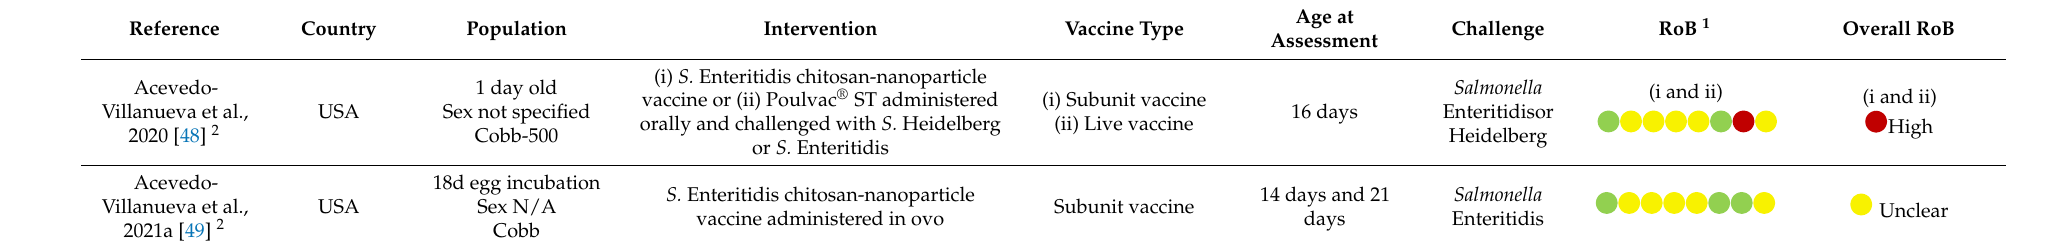
1 Risk of bias was assessed in the order of: Sequence generation, Allocation concealment, Timing of identification and Recruitment of individual participants, Blinding of participants and personnel, Blinding of outcome assessors, Incomplete outcome data, Selective outcome reporting and Other sources of bias. Assess- ment for each domain is represented in green (low risk of bias), yellow (unclear risk of bias) and red (high risk of bias). 2 Studies that did not have a unit of analysis error. Note: Population age refers to the bird’s age at the beginning of the intervention. Table 3. Summary of key characteristics of studies that investigated the effects of Salmonella vaccines on caecal Salmonella .